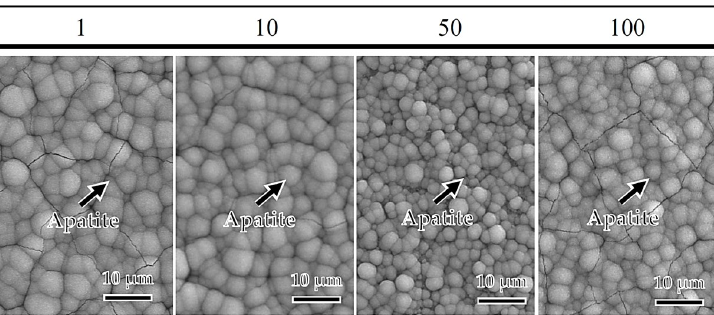
Figure 7. SEM images of the surface of Ti before and after soaked in SBF for 3 days that has been subjected to Sr + X mM Ag (pH = 4) treatment with various Ag concentrations ( X = 1–50) following NaOH, CaCl 2 , and heat treatment.